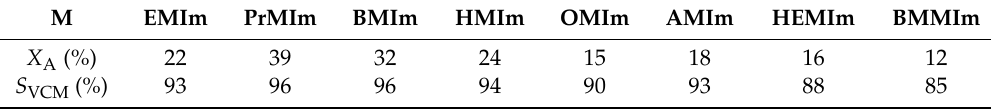
Table 1. Catalytic performance of CuCl 2 , using IL [M]Cl with di ff erent cations [M] + as the reaction media M EMIm PrMIm BMIm HMIm OMIm AMIm HEMIm BMMIm X A